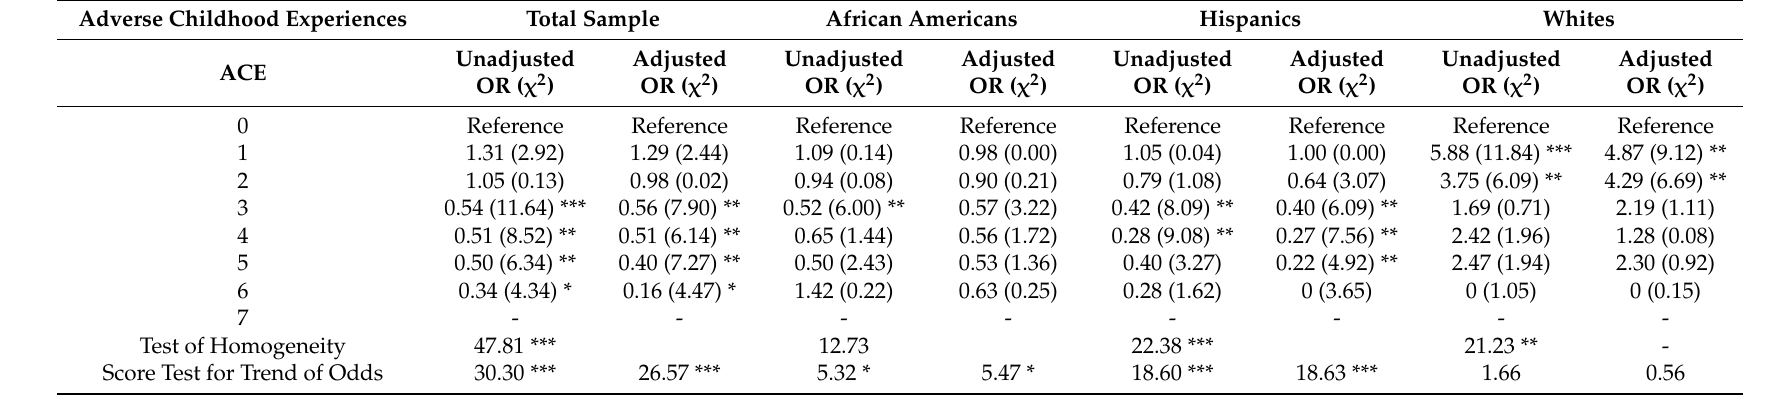
Table 3. Table of odds for serious person/property offense as commitment